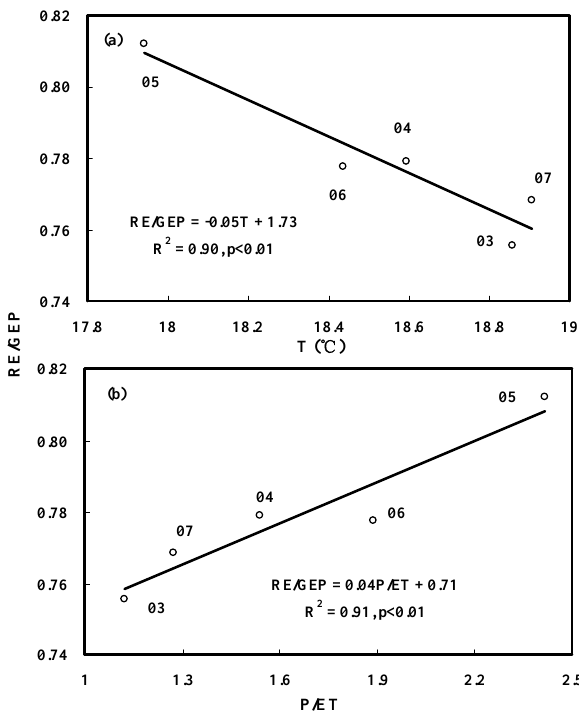
Fig. 8. The dependence of the ratios of yearly ecosystem respiration (RE) to gross ecosystem photosynthesis (GEP) on (a) air tempera- ture ( T ) and (b) water balance index ( P /ET) during 2003 to 2007 at Qianyanzhou site. The linear regression lines were